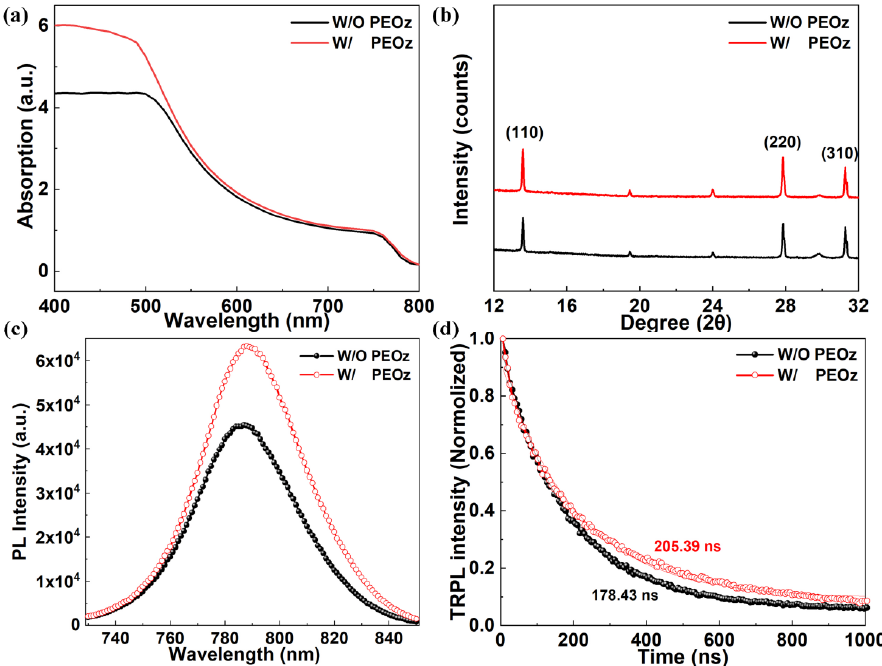
Figure 3. Optical properties and crystal structure of the as − prepared MA 0.7 FA 0.3 PbI 3 − x Cl x films with and without PEOz. ( a ) UV − Vis absorption spectra, ( b ) XRD patterns, ( c ) PL spectra and ( d ) normalized TRPL spectra of the pristine perovskite film and PEOz − treated perovskite film grown on the glass substrates.